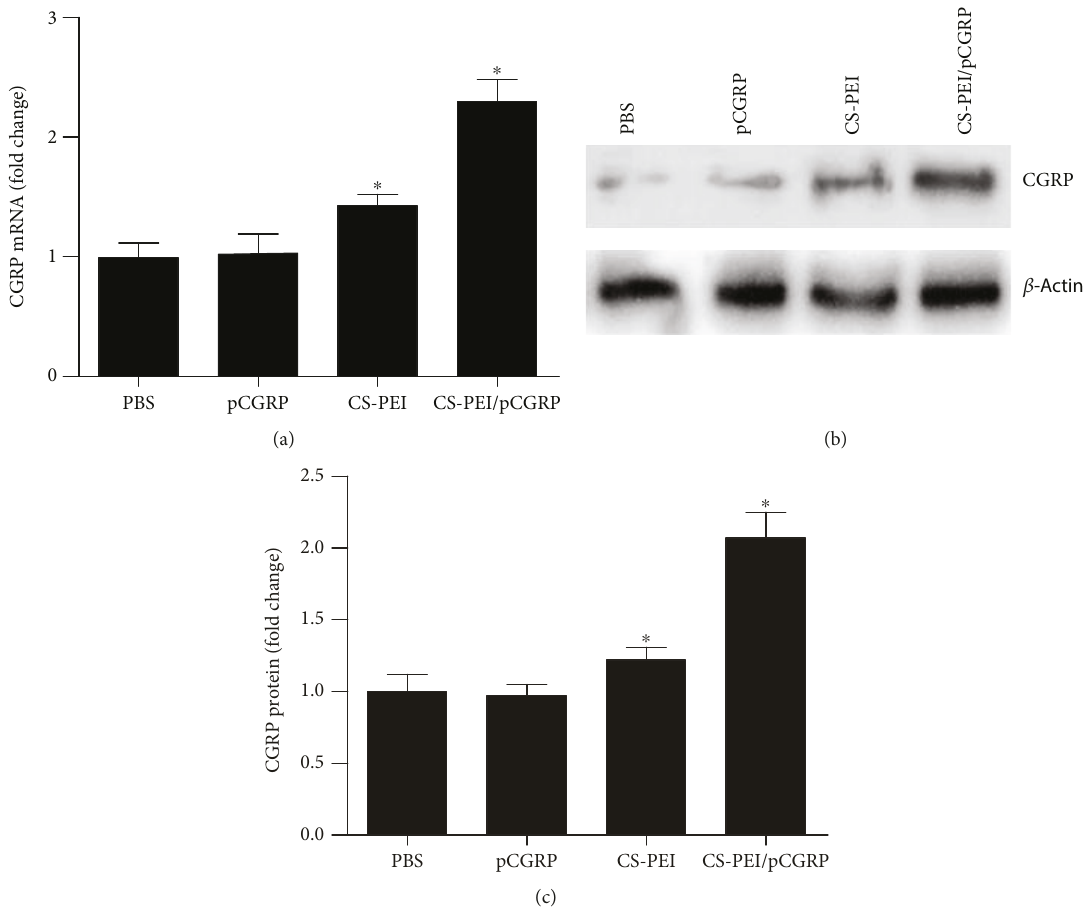
Figure 6: CGRP expression in callus of rat femoral fracture model after 3 weeks treatment with CS-PEI/pCGRP. (a) mRNA level of CGRP by RT-qPCR. (b) Representative image of CGRP bands for protein level by western blot. (c) The quanti fi ed result of CGRP bands. Data are mean ± standard deviation ( n = 4 ). ∗ P < 0 05 vs. the PBS